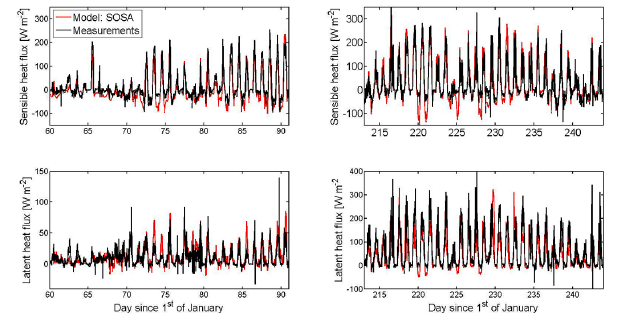
Fig. 4. Modelled and measured sensible and latent heat flux for March and August 2007 for SMEAR II, Hyyti¨al¨a at 23m above ground.